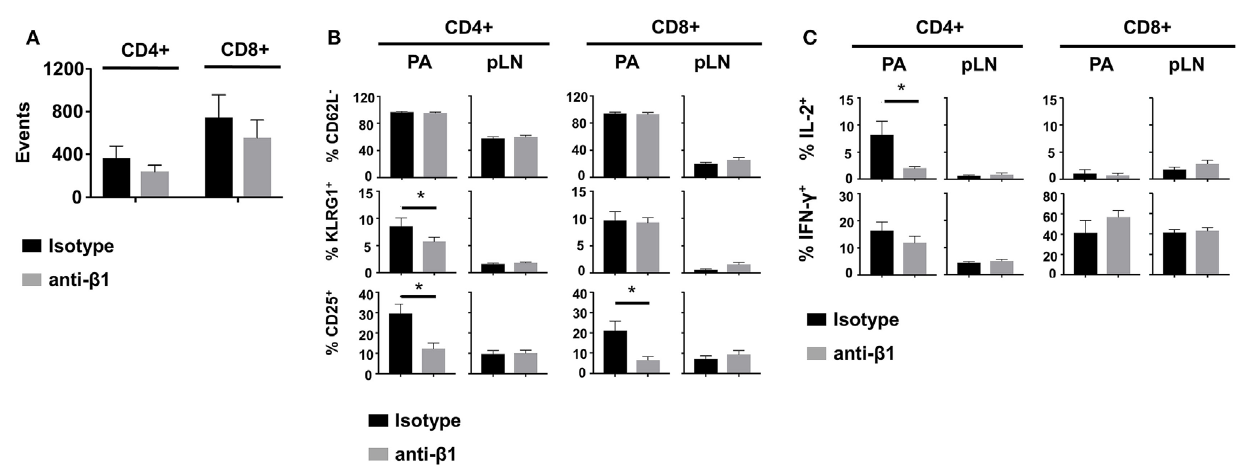
FigUre 6 | β 1 integrin blockade alters diabetogenic T cell effector phenotype in the pancreas (PA). Irradiated InsHA-mCherry mice transferred with Clone 4-GFP CD8 + and HNT-CFP CD4 + T cells were treated with anti- β 1 mAb or isotype control antibodies on days 8 and 9 after transfer. At day 10, donor T cells from pancreatic LN (pLN) and PA were analyzed by FACS gating on living CD8 + or CD4 + Thy1.1 + lymphocytes. (a) Donor T cells in the PA of treated mice. FACS event counts in the CD8 + or CD4 + Thy1.1 + gates from three independent experiments, represented as mean ± SEM ( n = 8 mice, Mann–Whitney). (B) Donor T cell expression of CD25, CD62L, and KLRG1. Percentages of indicated subpopulations in the CD8 + Thy1.1 + or CD4 + Thy1.1 + gates from three independent experiments, represented as mean ± SEM ( n = 8 mice, Mann–Whitney). (c) Intracellular cytokine measurement in donor T cells. Percentages of IL-2 + or IFN γ + cells in the CD8 + Thy1.1 + or CD4 + Thy1.1 + gates from two independent experiments, represented as mean ± SEM ( n = 6 mice,